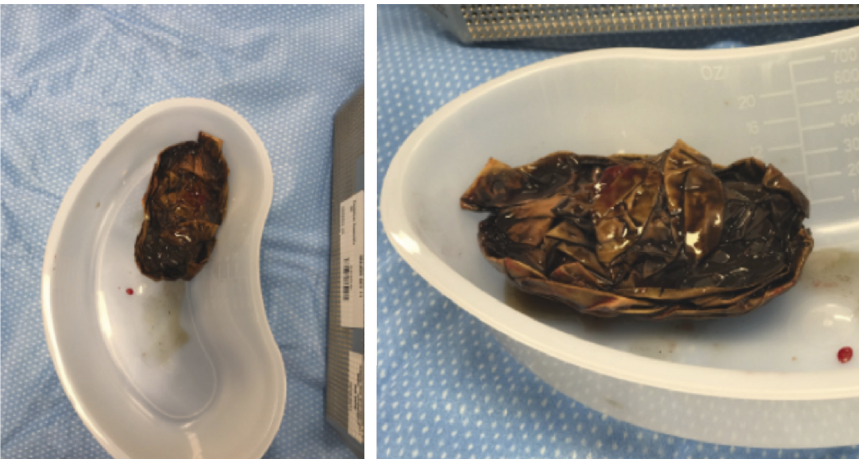
Figure 3: Images depicting the gastric bezoar composed of rigid plastic gloves that has just been removed via anterior